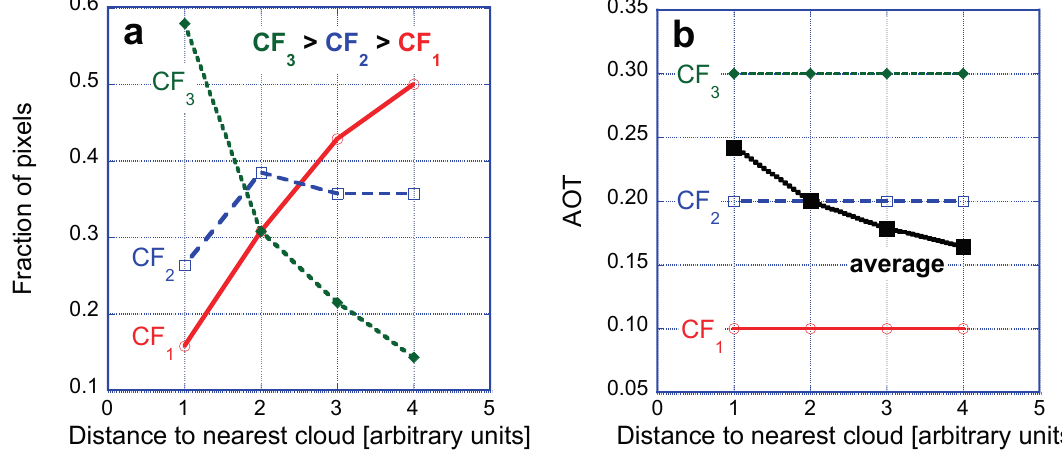
Figure 1. Schematic plots illustrating that mean aerosol optical thickness (AOT) can appear to increase towards clouds if the cloud fraction (CF) distribution changes. ( a ) Hypothetical fractions of samples. Higher and lower CFs are more frequent close to clouds and far from clouds, respectively. ( b ) Hypothetical mean AOTs. Colored lines correspond to CFs in panel (a). They show AOTs that don’t change near clouds but are correlated with CF. Black line shows overall mean AOT when combining data from all three